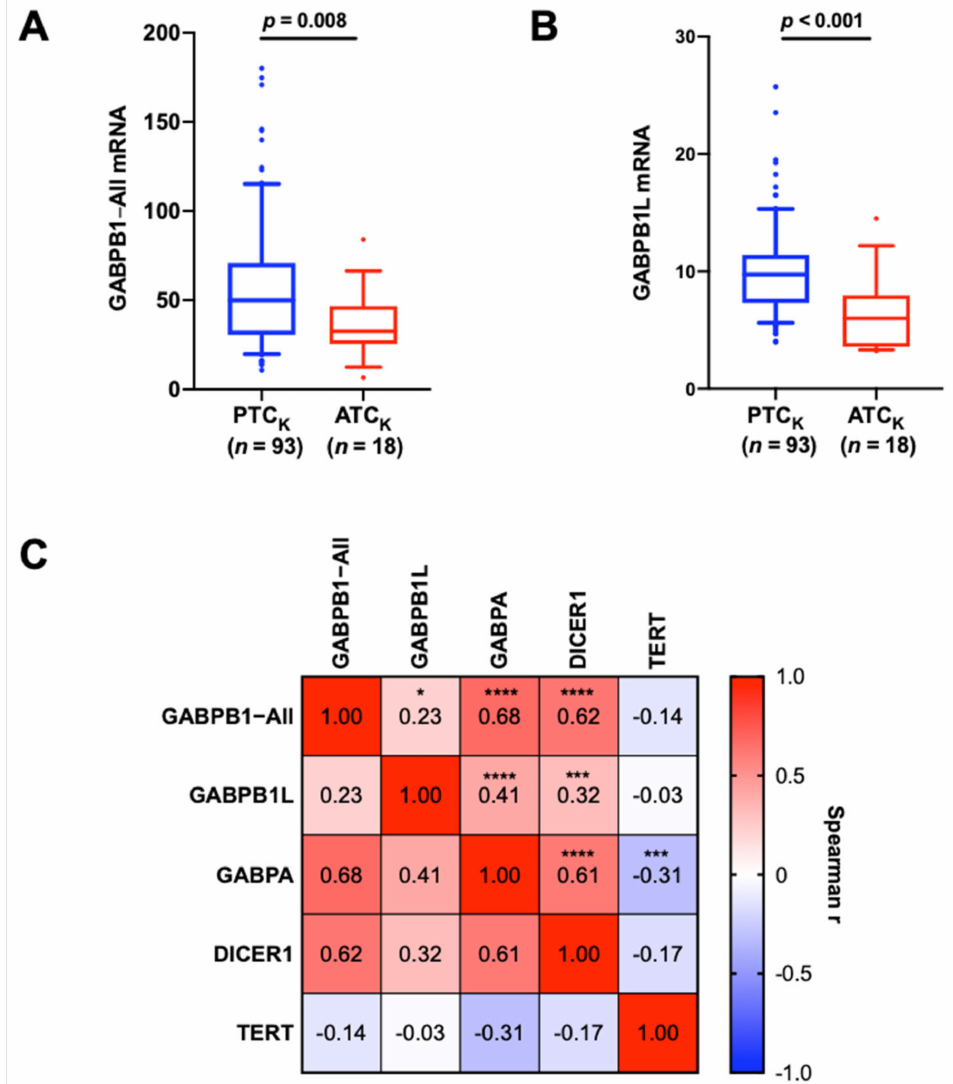
Figure 2. GABPB1 mRNA expression levels are associated with aggressive TCs, and positively correlated with GABPA and DICER1 expression. Gene expression levels were determined using qPCR. ( A , B ) Significantly lower expression of GABPB1 − All and GABPB1L in ATC K than in PTC K , respectively. ( C ) Correlation matrix for analyses between GABPB1 − All , GABPB1L , GABPA , DICER1, and TERT mRNA levels in PTC K . Spearman correlation r values are illustrated in color from blue ( − 1) to red (1). GABPB1 − All : total amount of GABPB1 mRNAs; including all transcript variants of GABPB1 ; GABPB1L: long variant of GABPB1 mRNA; * p < 0.05; *** p < 0.001; **** p <